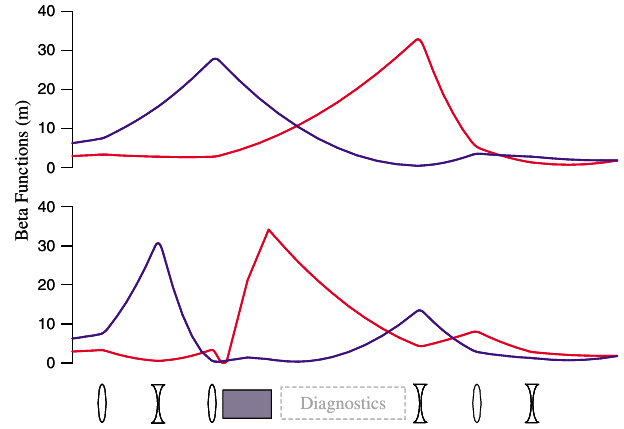
FIG. 8. (Color) Nominal betatron functions in the 4F region of the FEL (top) and with a solenoid (blue) activated to produce a 90 (cid:1) rotation of betatron planes with the upstream and down- stream quadrupole triplets used for matching (bottom). Horizontal betatron functions are denoted in red and vertical in